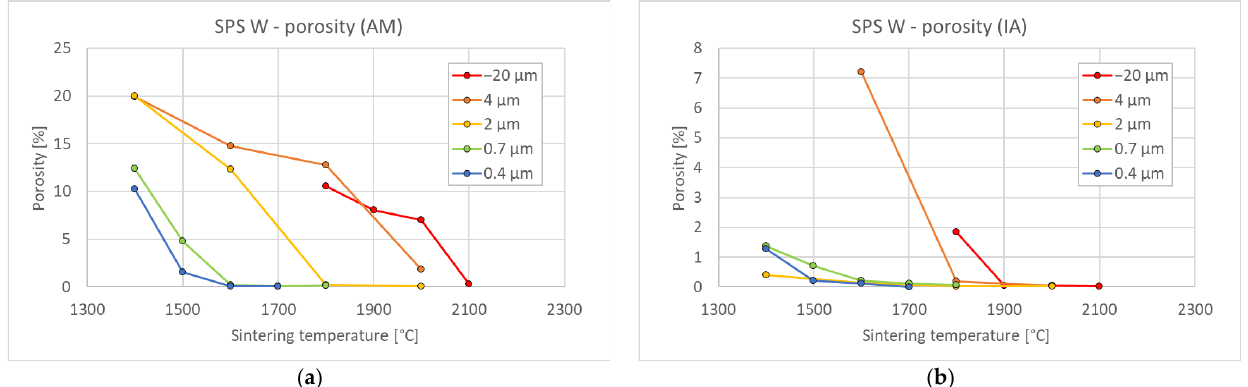
Figure 1. Effect of sintering temperature on porosity for tungsten of different powder sizes; ( a ) results from Archimedean method (AM), entire sample; ( b ) image analysis (IA), dense central region.